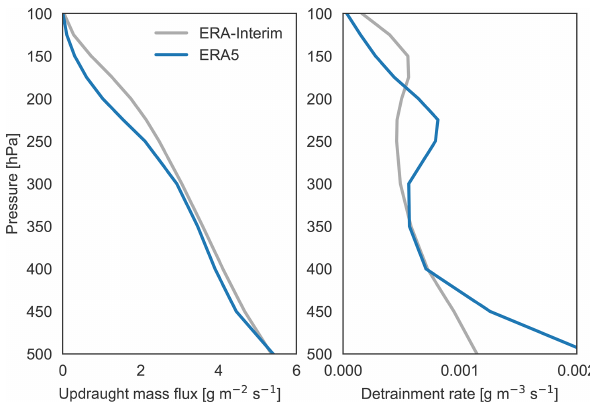
Figure A2. Vertical profiles of updraught mass fluxes and frac- tional detrainment rates in ERA5 (blue) and ERA-Interim (grey) for 10 ◦ S–10 ◦ N during January